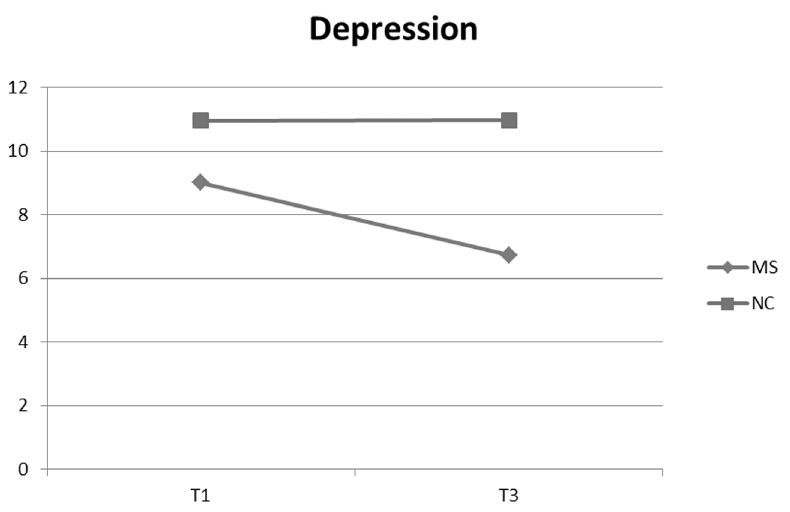
Figure 1. Writing conditions and mean of depression scores at T1 and T3.